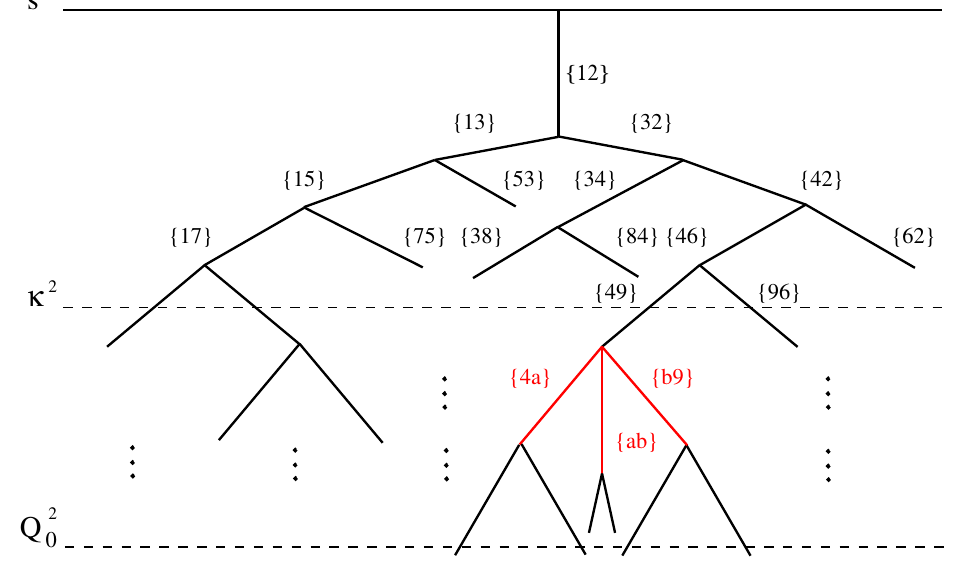
Figure 2 . Example of an evolution tree of dipole { 12 } . Each edge in the graph corresponds to a dipole. The nodes correspond to an iteration of Z (0) [ Q ; { u } ] except for the (red) node describing the splitting of dipole { 49 } which indicates the double emission insertion in the r.h.s. of the evolution equation (3.15) for Z (1) [ Q ; { u } ]